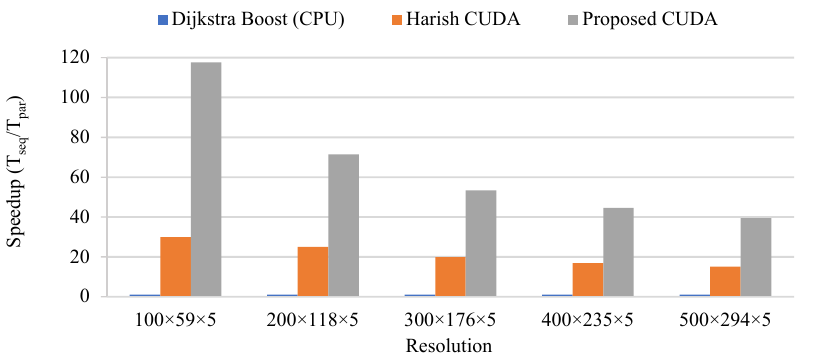
Figure 16. Speed-up of the three SSSP implementations tested.